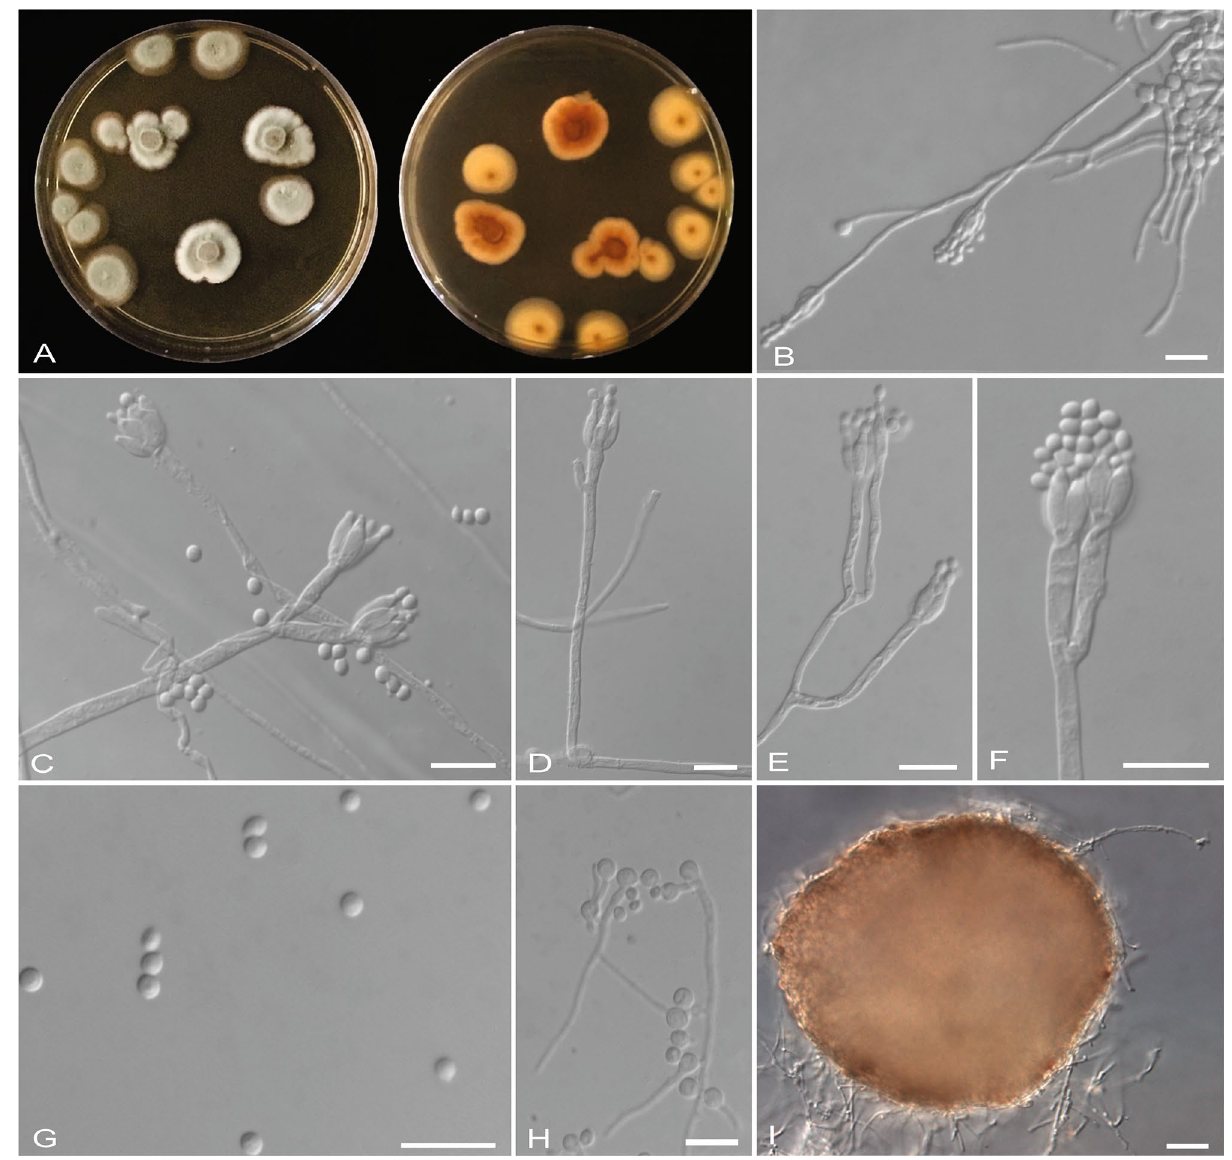
Figure 2. Penicillium cerradense sp. nov. ( A ) Colony appearance (surface and reverse) after 7 days of growth on malt extract agar at 25 ± 2 °C. ( B–D ) Conidiophores. ( E, F ) Conidiogenic apparatus with ampulliform phialides. ( G ) Conidia. ( H ) Conidia germinating after 48 h. ( I ) Sclerotia. Scale Bar: B ‒ H = 10 μm, I = 50 μm.